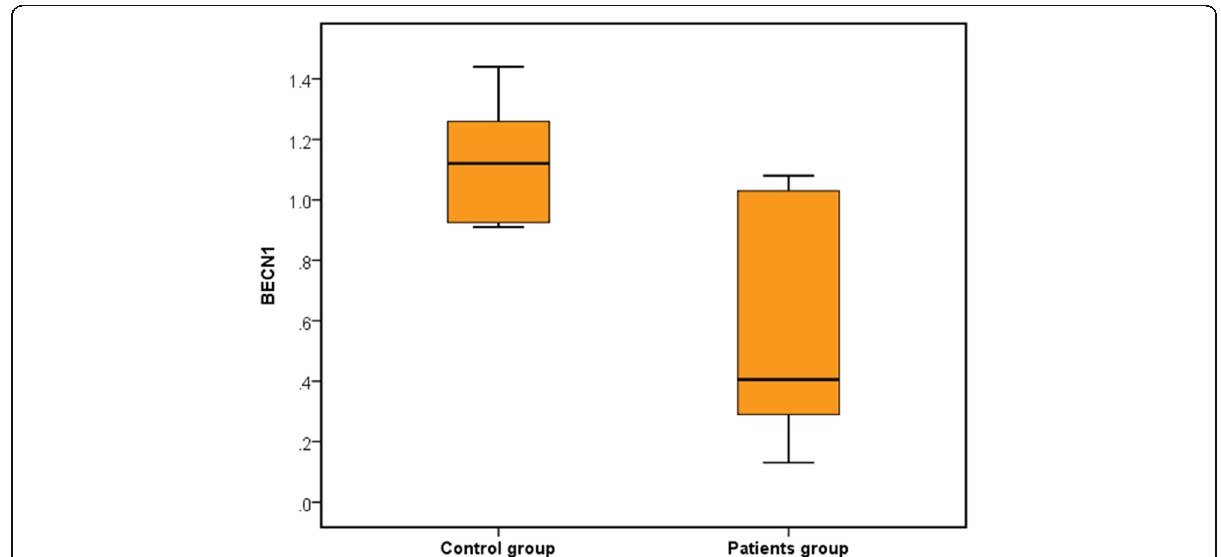
Fig. 1 Comparing the median of BECN1 gene expression of AML patients and the control